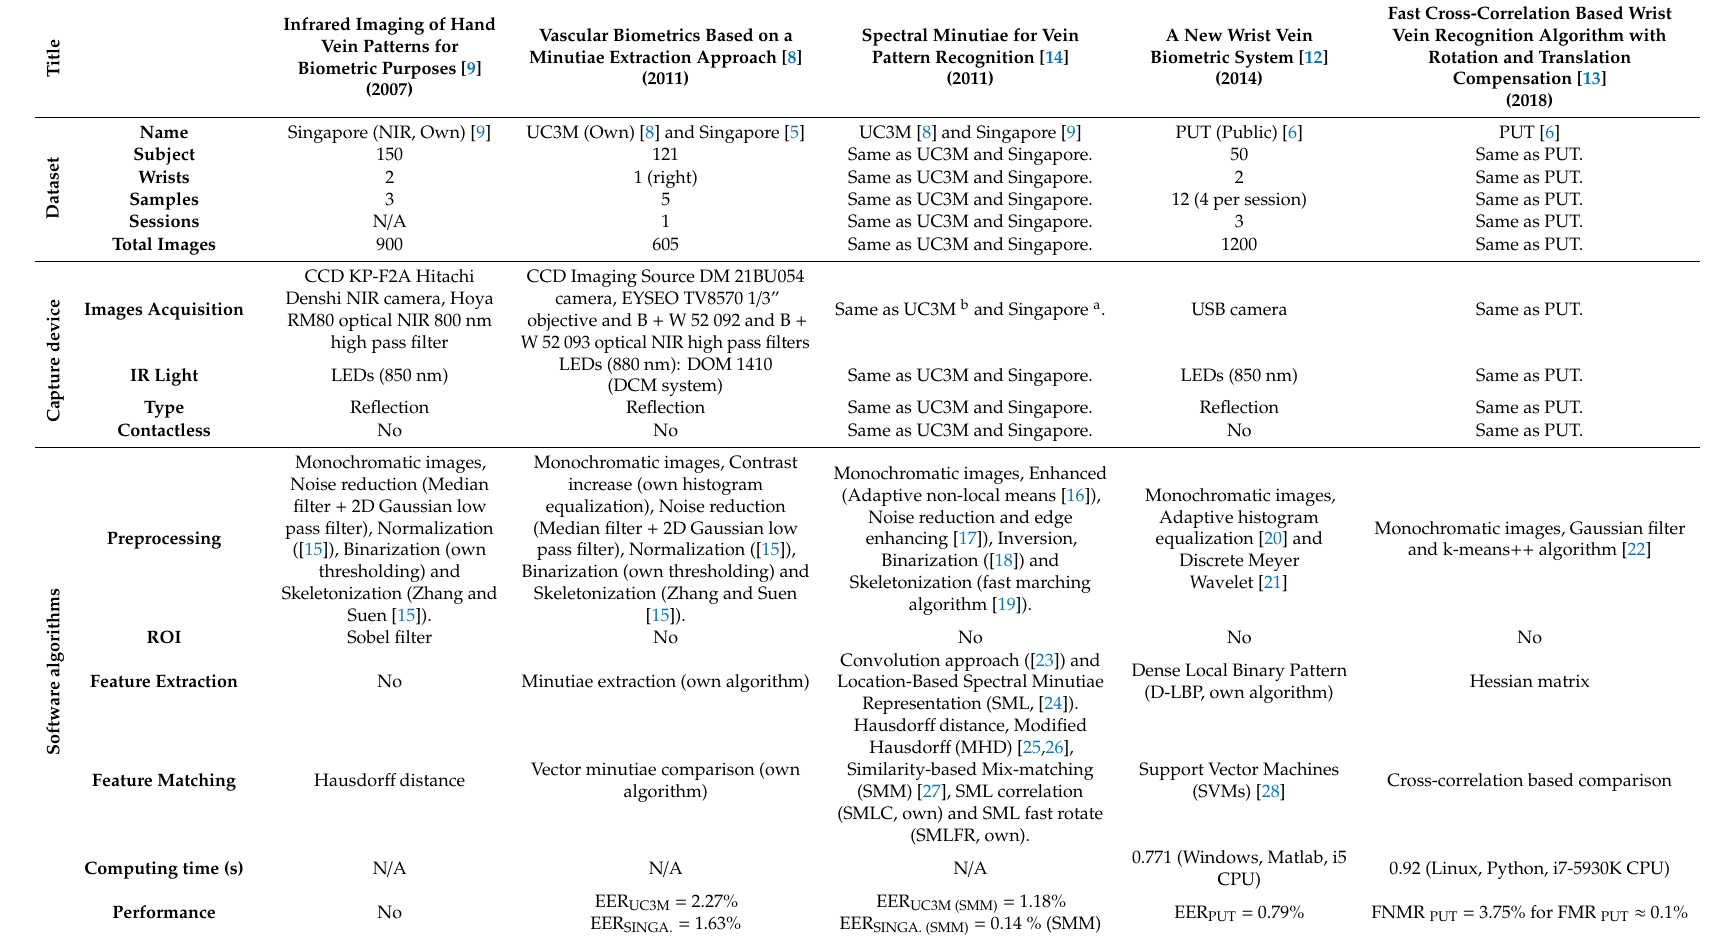
Table 1. Summary of the state-of-the-art for wrist Vascular Biometric Recognition